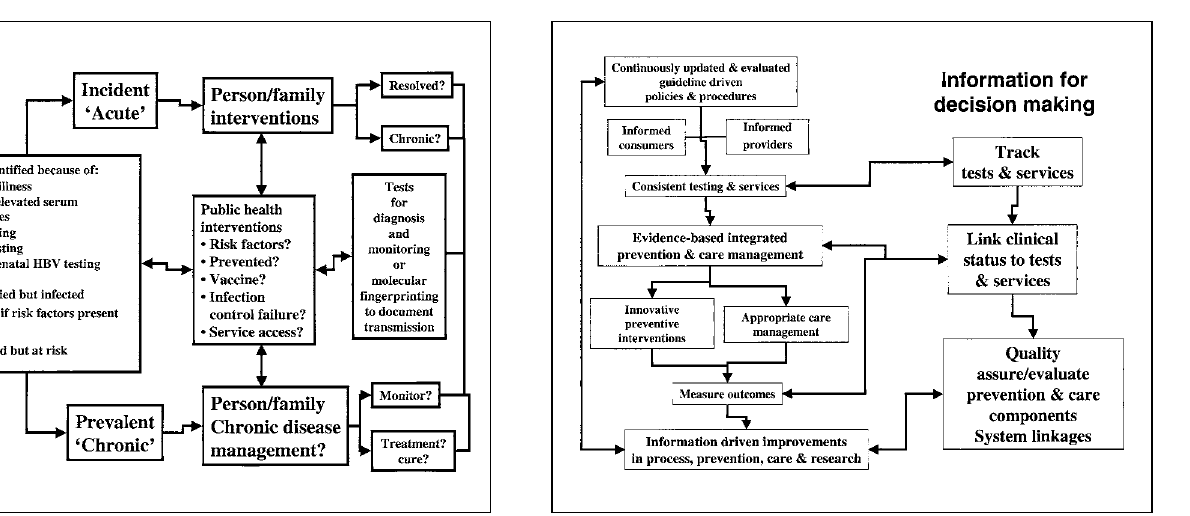
Figure 2) An integrated model of hepatitis service